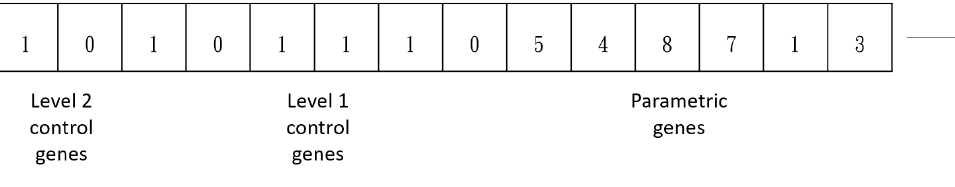
Figure 2. An example of chromosome representation.